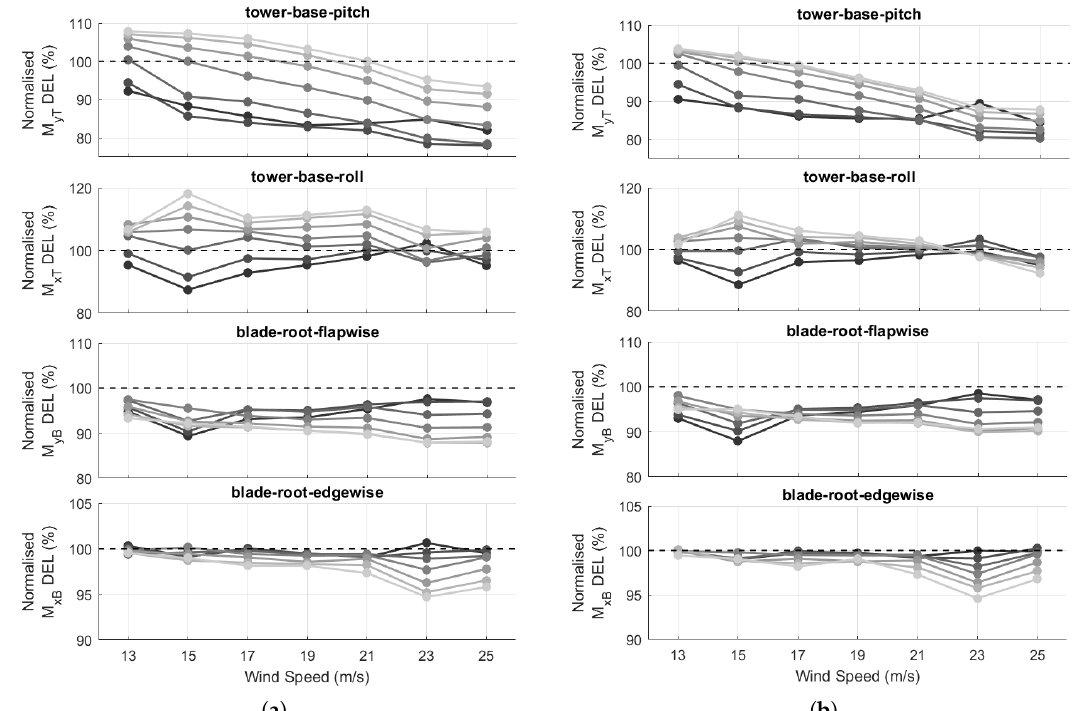
Figure 7. Damage Equivalent Load relatives to the baseline Detuned PI results (dashed lines) for H s = 0...6 m (decreasing darkness for increasing H s ). ( a ) Manually tuned APS & WR. ( b ) Optimised APS &